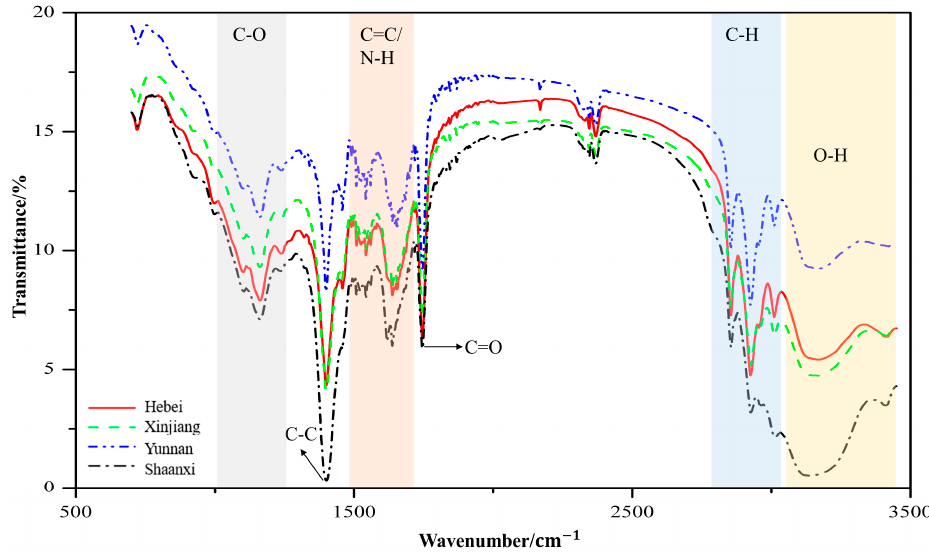
Figure 1. The preprocessed mean spectra calculated from each geographic origin.